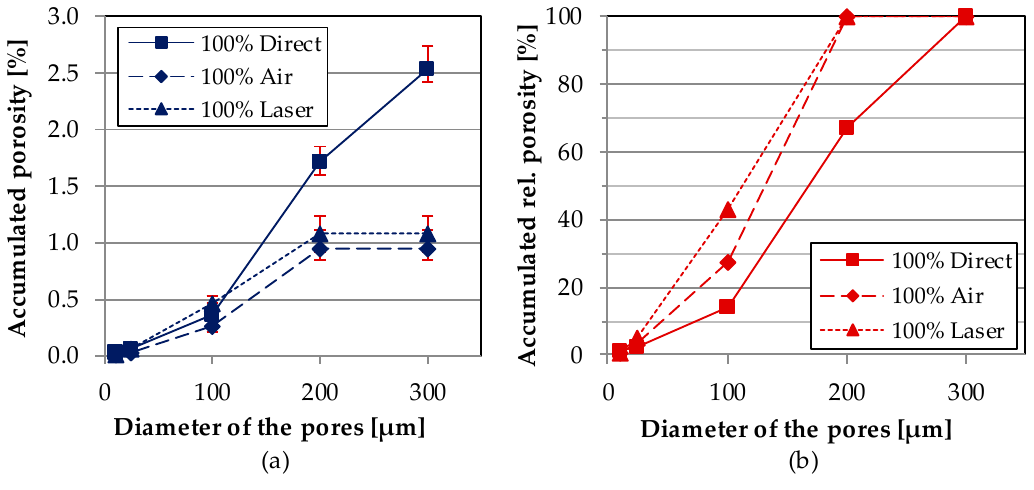
Figure 9. Accumulated porosity with respect to pore size in ( a ) total; ( b ) relative terms.